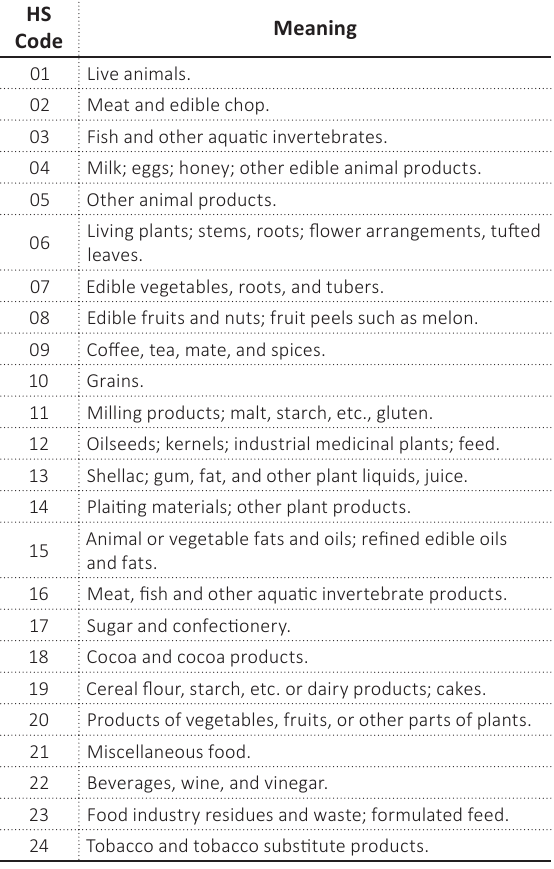
Table 1. HS12 classification of agricultural products